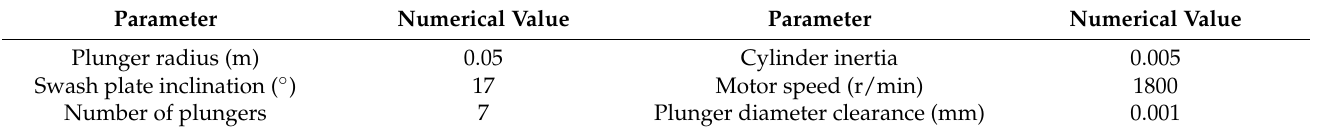
Table 1. Parameter setting of the plunger pump model.